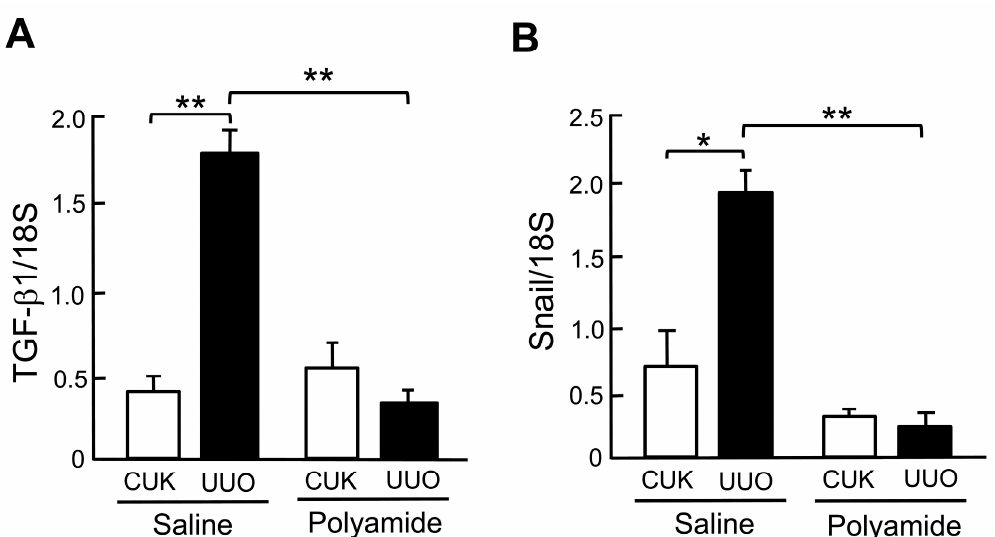
Figure 7. The effects of pyrrole-imidazole polyamide targeting human TGF- β 1 (Polyamide) on the expression of TGF- β 1 and Snail mRNAs in the kidney with unilateral urethral obstruction (UUO) in marmosets with UUO. The left ureter was ligated, whereas, in the sham-operated marmosets, the left ureter was not disturbed. Marmosets with UUO were intravenously injected with Polyamide (1 mg / kg / week for four weeks) through the tail vein from one week after the operation. Control marmosets with UUO were intravenously injected with same amount of saline through the tail vein. CUK, contralateral unobstructed kidneys. Data indicate the mean ± SEM ( n = 6). * p < 0.05 and ** p < 0.01 in the indicated columns.